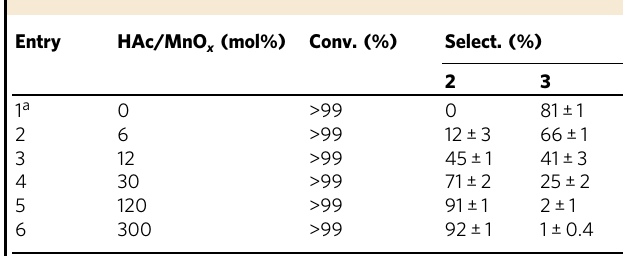
Fig. 5 Performance of MnO x with different modi fi ers in the ammoxidation of 4-hydroxymethylbenzaldehyde. Reaction conditions: 0.5 mmol 4- hydroxymethylbenzaldehyde, 0.17 mmol MnO x , additive/MnO x = 120 mol%, 5 mL CH 3 CN, 0.3 MPa NH3, 0.3 MPa O 2 , at 80 °C for 3 h Table 1 Performance of manganese oxides with different CN0.3 MPa O 2 , 120 µ L aq. NH 3 amount of HAc modi fi ers in ammoxidation of 4-